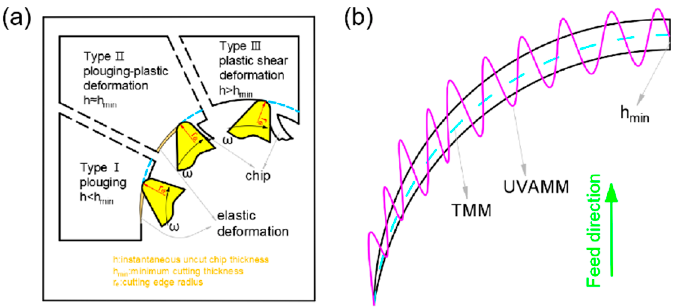
Figure 3. ( a ) Micromilling chip formation process in a single cutting cycle; ( b ) ultrasonic vibration Figure 3. ( a ): Micromilling chip formation process in a single cutting cycle; ( b ): ultrasonic vibration increases h in cutting process. increases h in cutting process.